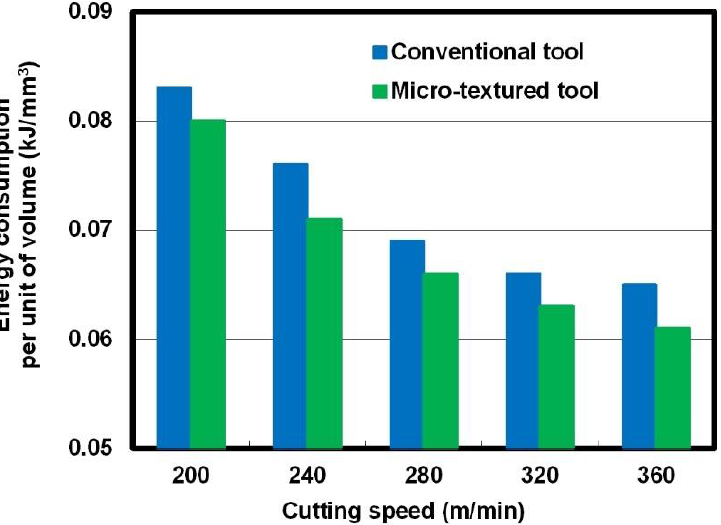
Figure 7. Energy consumption per unit of volume for operations with different cutting tools.